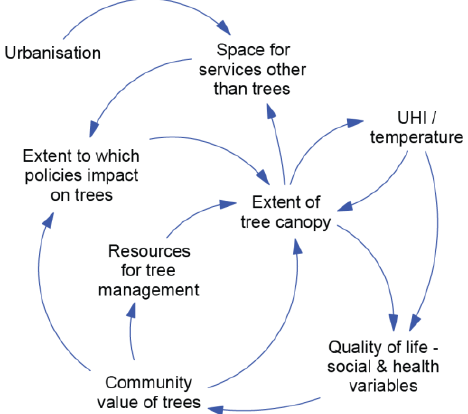
Figure 6. Development and Environment Sector Influence Diagram.